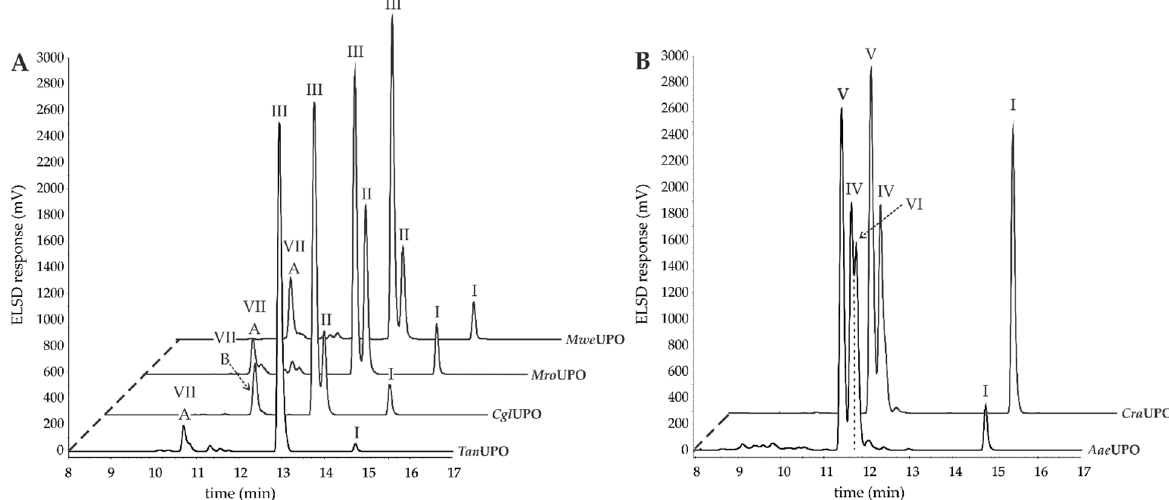
Figure 2. HPLC analysis (elution profiles recorded by ELSD) of products formed by different UPOs during the conversion of AA over 2 h. The reactions were carried out with 1 mM AA in 20 mM sodium phosphate buffer (pH 7.0), in presence of 20% ( v / v ) acetone, 2% ( w / v ) glucose, 2 U mL − 1 UPO and 0.04 U mL − 1 glucose oxidase. ( A ): HPLC-ELSD elution profiles of EETs formed. I: Arachidonic acid; II: 11,12-EET; III: 14,15-EET; VII A: Metabolite with m / z 335; VII B: metabolite with m / z 335. ( B ):